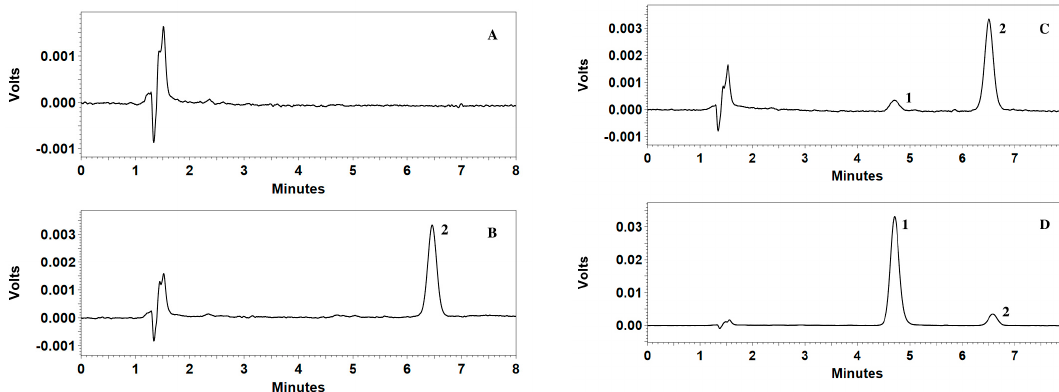
Figure 2. Typical chromatograms of HPLC of the blank dog plasma ( A ); blank dog plasma spiked with IS (25.00 μ g/mL) ( B ); blank dog plasma spiked with CMME (0.05 μ g/mL) and IS (25.00 μ g/mL) ( C ) and dog plasma sample obtained 2 min after a single intravenous administration of 1.2 mg/kg spiked with IS ( D ). Peak 1: CMME; peak 2:IS.